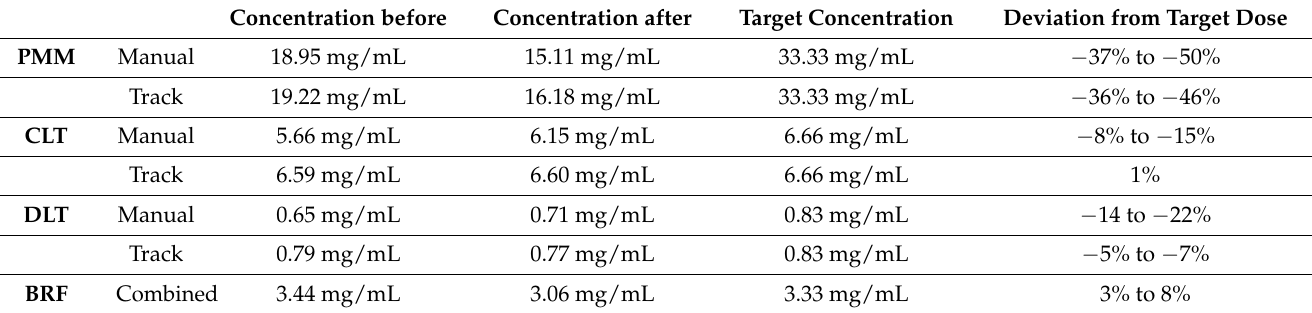
Table 3. HPLC results of liquid samples taken from the spray tank before and after spraying. The target dose in mg/m 2 is given for each active ingredient. HPLC results are represented as a percentage deviation from the target